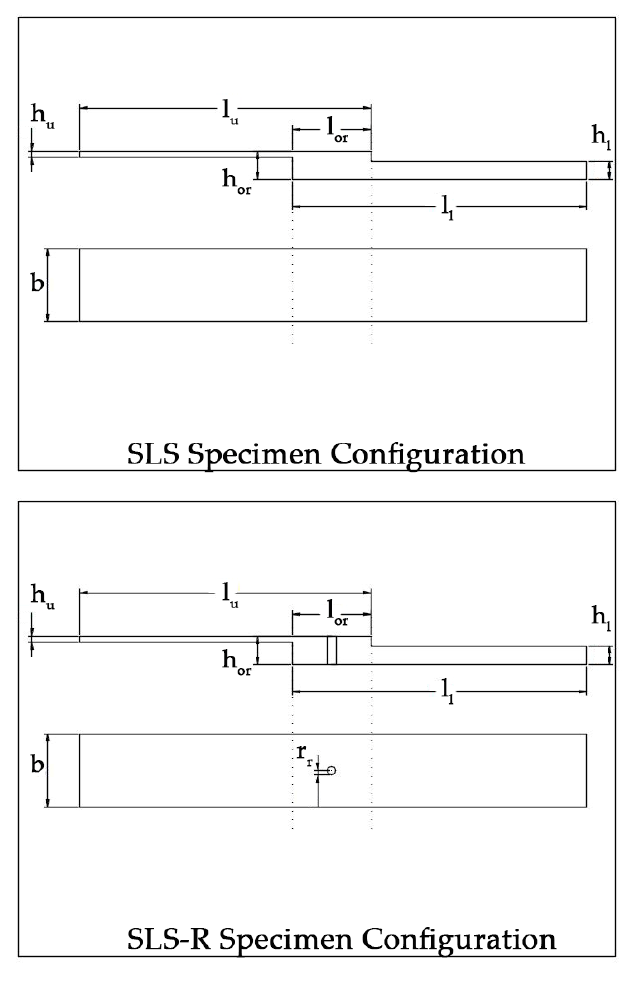
Figure 1. Configuration of SLS and SLS-R Specimens.